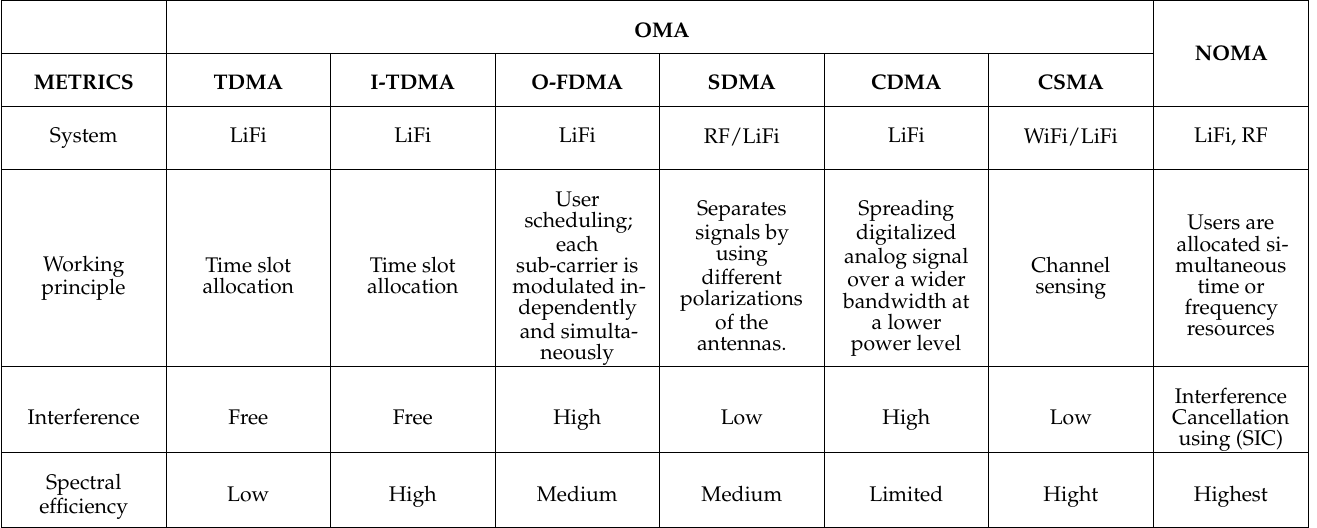
Table 6. NOMA and OMA types with their characteristics